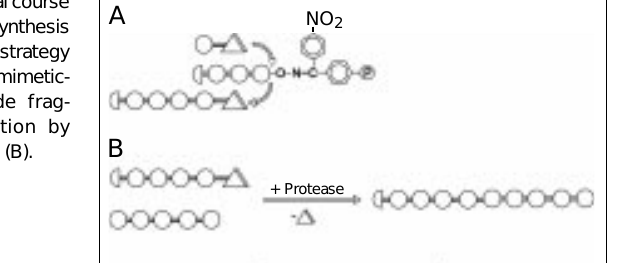
Figure 10 - General course of peptide ester synthesis via oxime resin